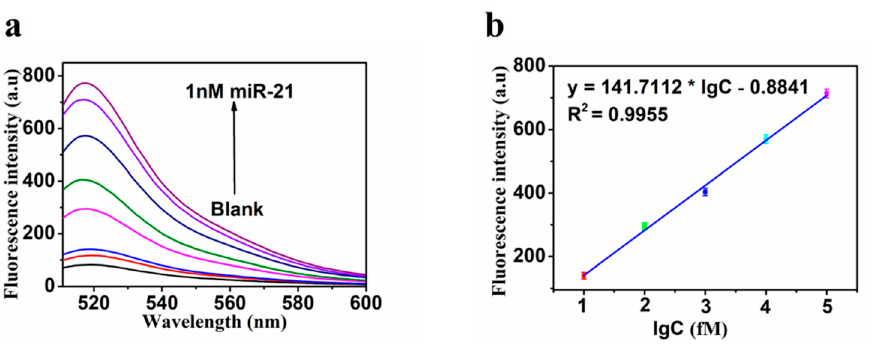
Figure 5. ( a ) Fluorescence emission spectra of the biosensor in the presence of miR-21 with different concentrations (0, 1 fM,10 fM, 100 fM, 1 pM, 10 pM, 100 pM, 1 nM); ( b ) fluorescence intensity as a function of miR-21 concentration. Error bars: SD, n = 3.